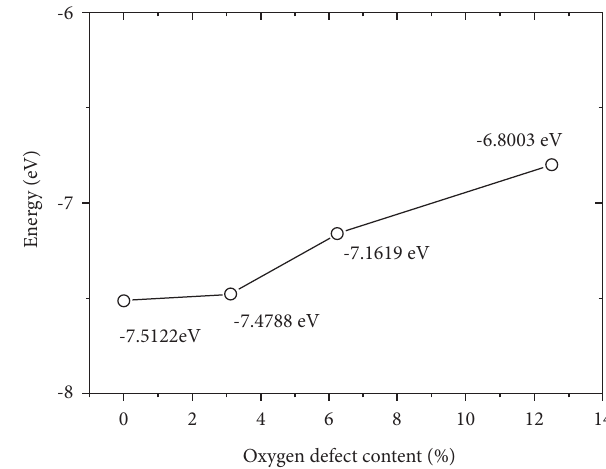
Figure 4: Normalized total energy increment for oxygen-defected TiO 2 as a function of content.